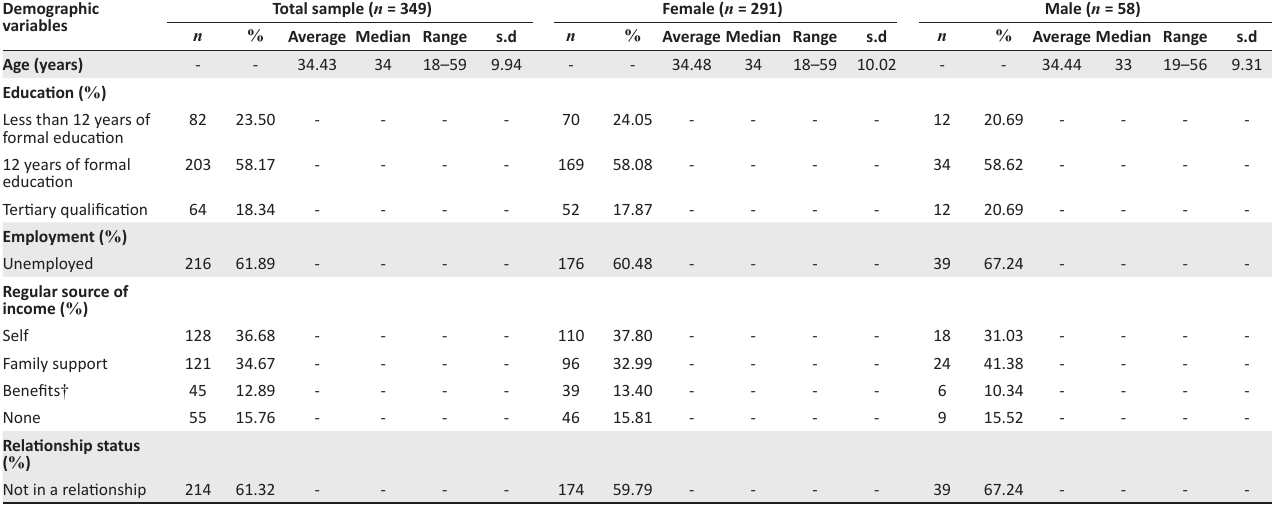
TABLE 1: Demographic characteristics of total sample. Demographic